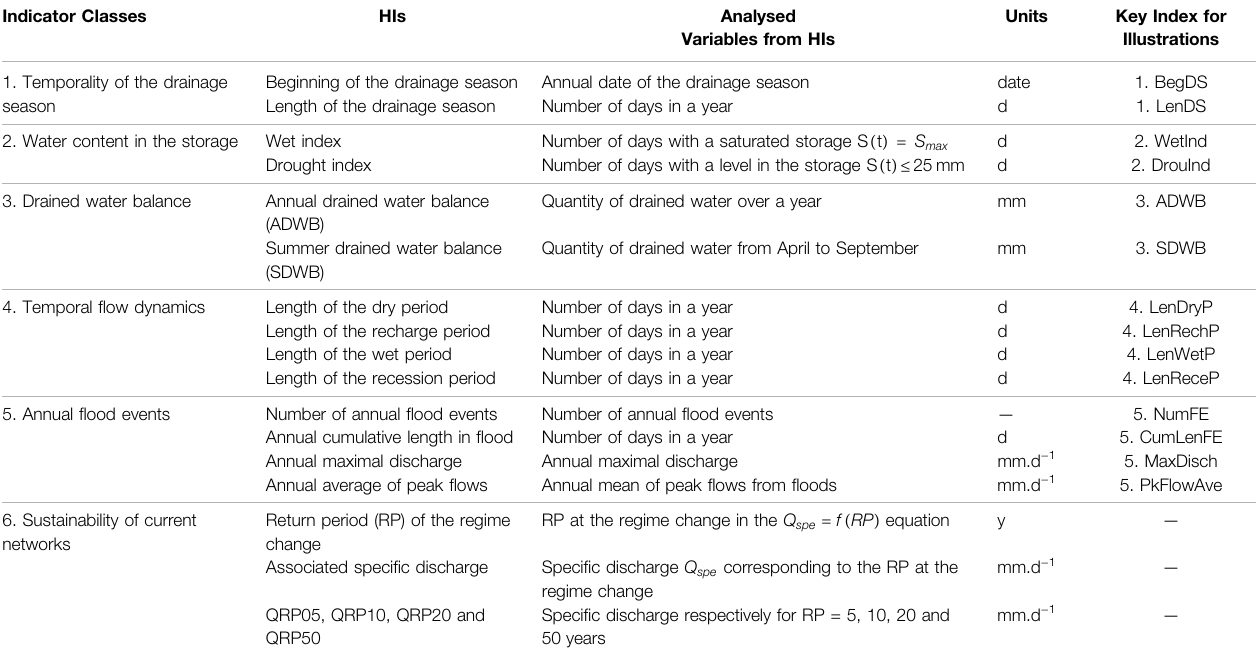
TABLE 2 | Hydrological indicators (HIs) and corresponding variables analysed. Indicator